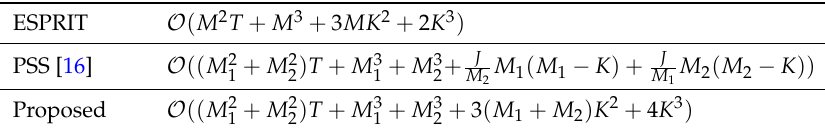
Table 2. Computational complexity